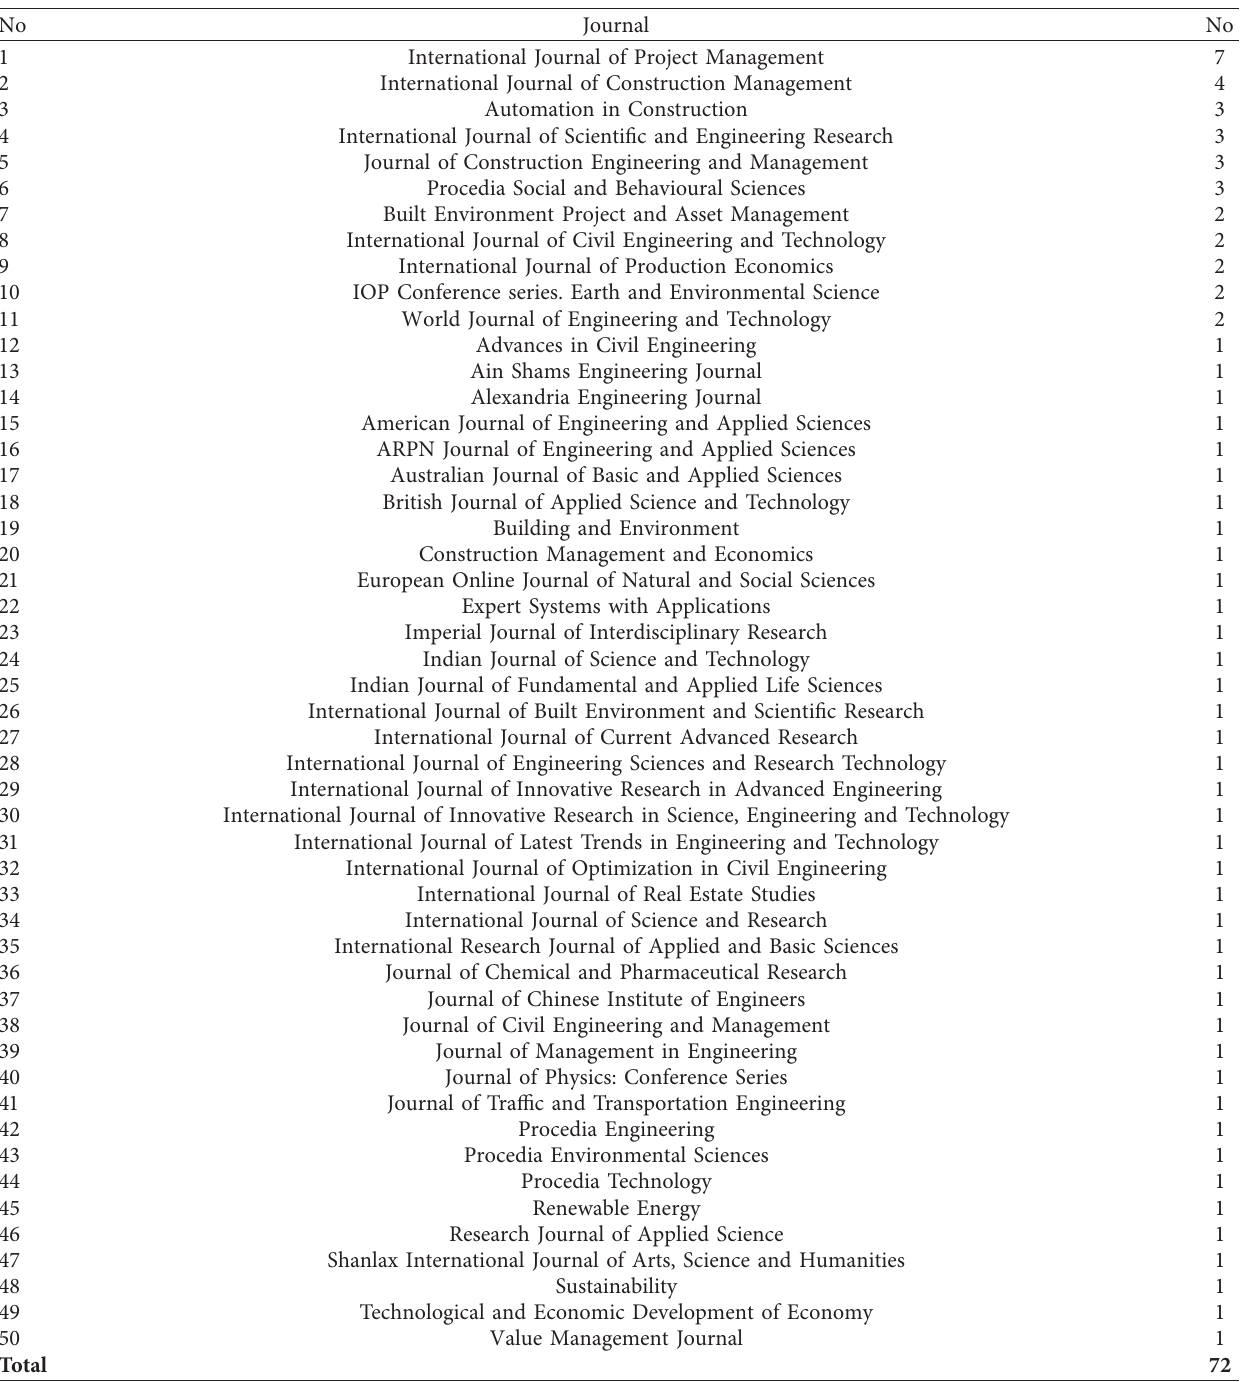
Table 1: Distribution of journal